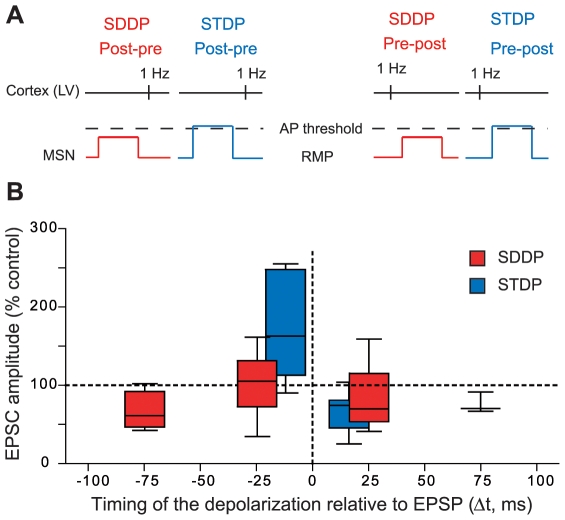
Comparison of the occurrence, orientation, magnitude and temporal extent of SDDP and STDP.(A) Schematic representations of post-pre and pre-post SDDP and STDP protocols (the two protocols differ by the presence or not of a postsynaptic action potential). (B) Long-term synaptic efficacy changes evoked by SDDP and STDP protocols illustrated with Box and Whiskers plots. When compared to SDDP, STDP changes were strictly orientated. SDDP changes were inducible in wider time windows than STDP (+/−110 vs. +/−30 ms). sdLTP were induced in a time window 1.7 fold wider than those of STDP LTP while the time window for sdLTD induction was 3.3 fold wider when compared to STDP LTD. Data concerning STDP experiments are taken partly from a previous study (Fino et al., 2005), with the addition of new experiments performed in perforated patch-clamp (n = 6).